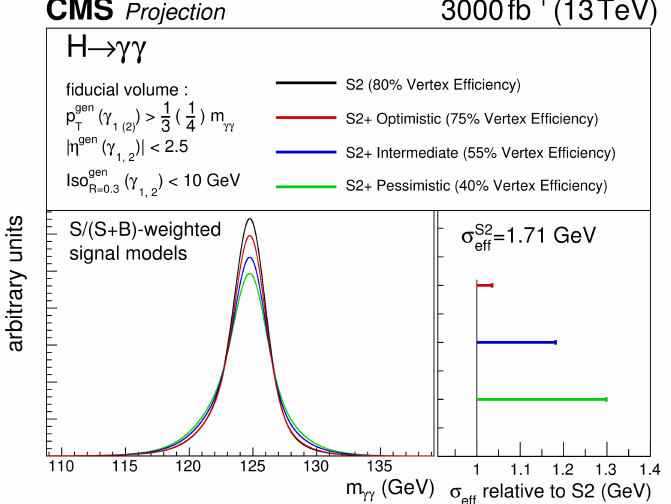
Figure 9. Lineshape for the H → γγ signal in the four scenarios: no precise timing (green), precise timing in calorimeter (blue), precise timing in calorimeter and MIP timing (red) and Run 2 conditions (black)